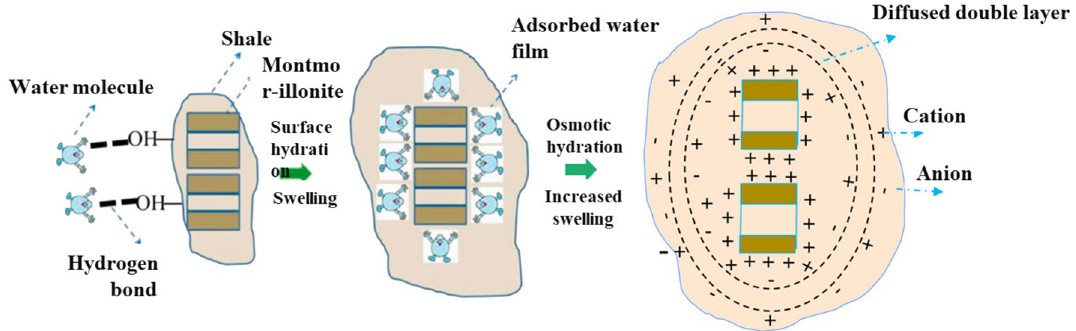
Figure 3. Schematic diagram of rock hydration mechanism